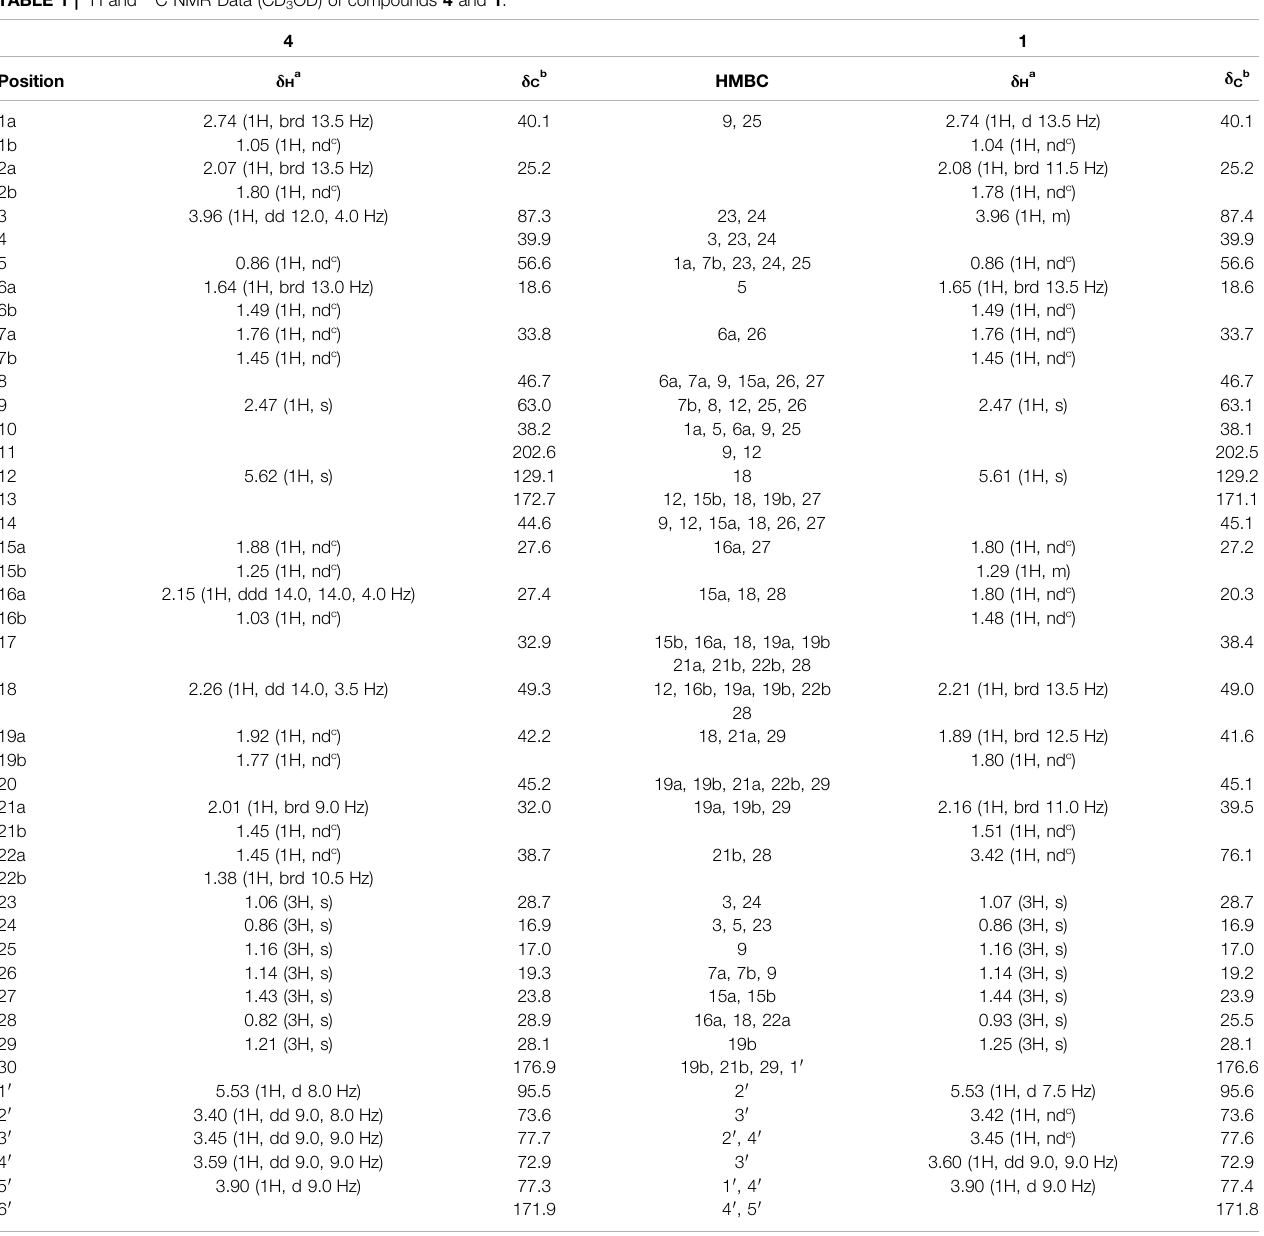
TABLE 1 | 1 H and 13 C NMR Data (CD 3 OD) of compounds 4 and 1